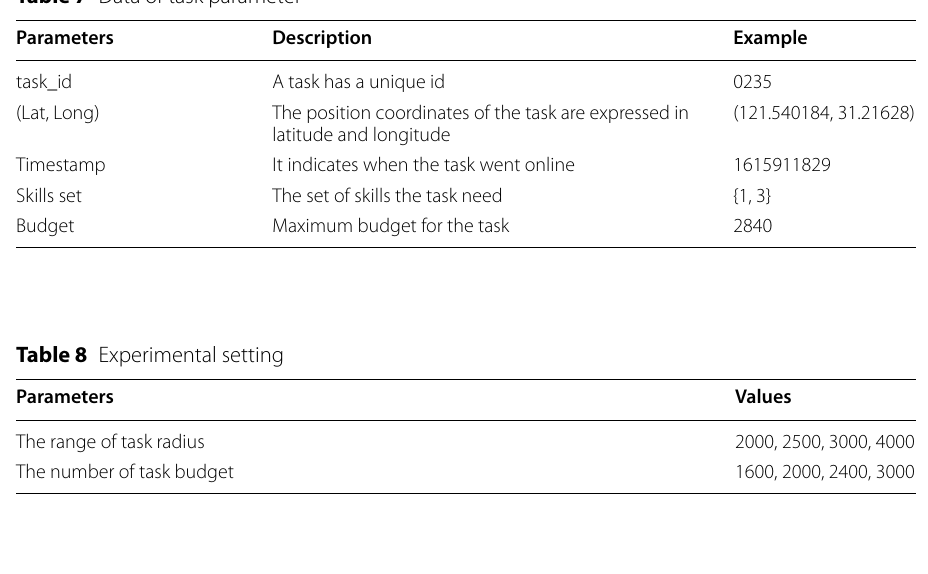
Table 7 Data of task parameter